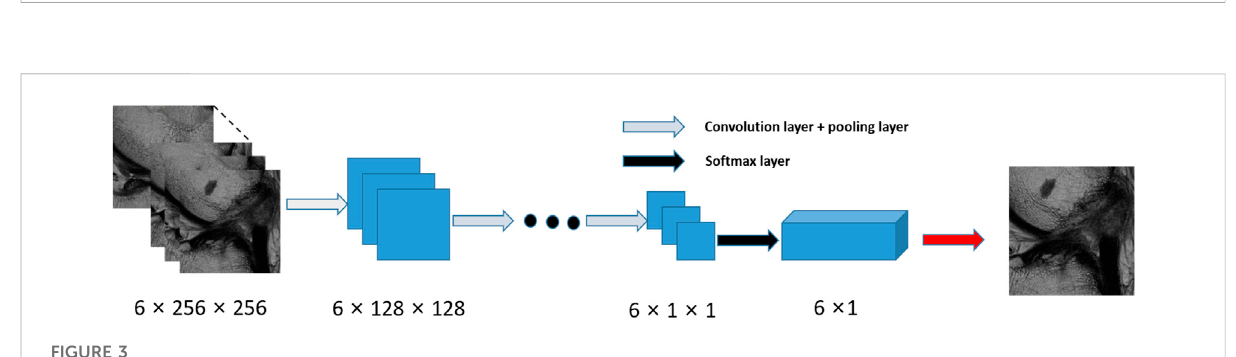
FIGURE 3 Flow chart for the slice detection network of 2D